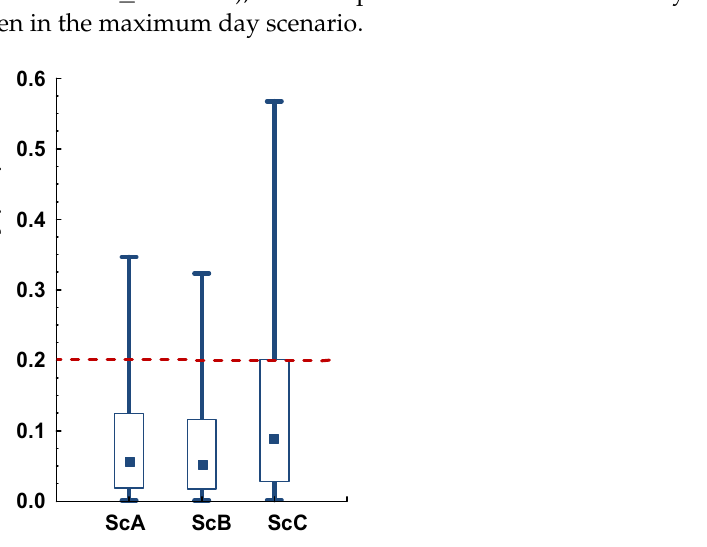
Figure 7. Maximum velocity distribution for scenarios of average day (ScA), average winter day (ScB), and maximum day (ScC) (Table 2). Median; Box: 25–75%; Whisker: 5–95%.